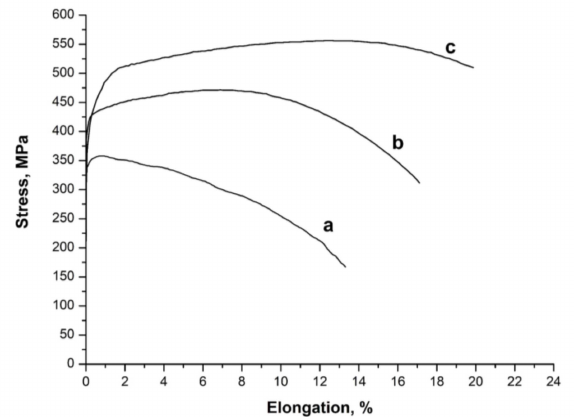
Figure 8. Stress curves: ( a ) initial state, ( b ) ECAP with wire forming, and ( c ) ECAP with wire forming +